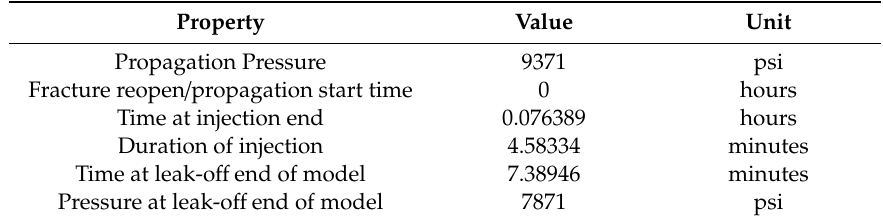
Figure 7. Calculated bottom hole pressure vs. time for Well 3H. Table 5. Parameters gathered from DFIT data used for Time-Stepped Linear Superposition Method (TLSM) simulation.